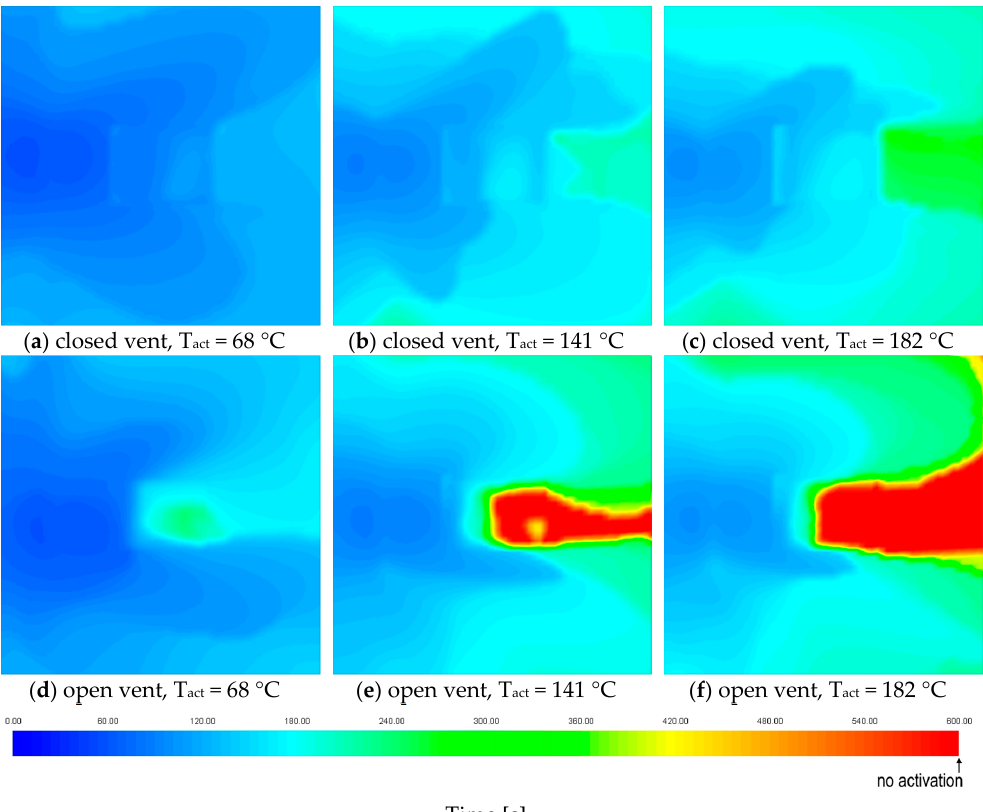
Figure 8. 2D plots of sprinkler activation time 20 cm underneath the ceiling in the region described in Figure 4. Results for fire scenario 2.